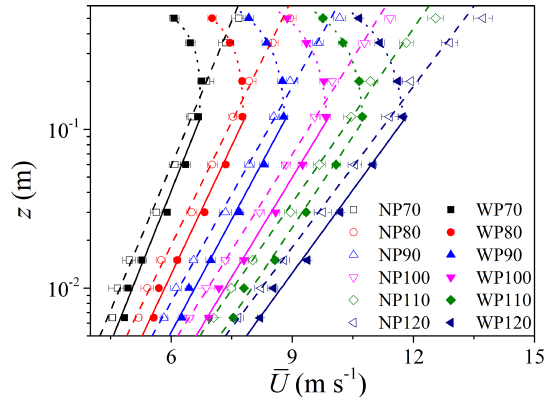
Figure 3. Mean flow speed profiles for different runs. For all cases, the wind-tunnel floor is covered by sandpaper. The trays filled with particles and mounted flush to the tunnel floor do not affect the mea- sured